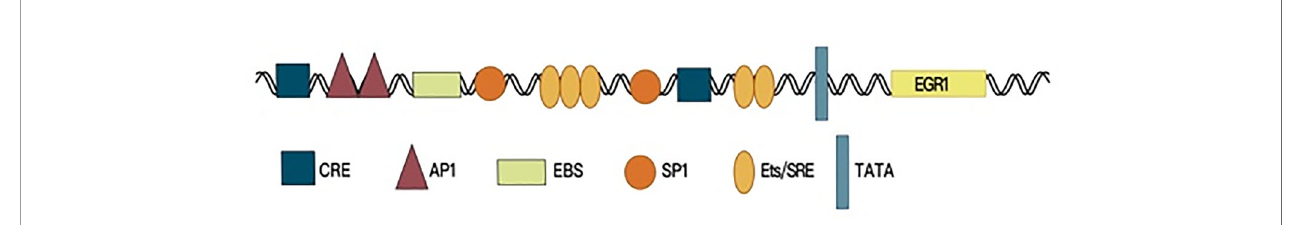
FIGURE 1 | The promoter region structure